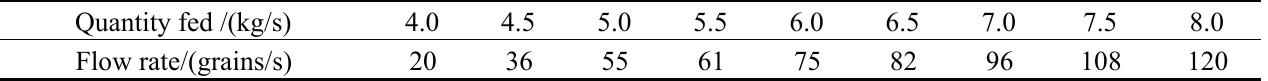
Table 2. Grain flow rate in sensor monitoring regional under different feeding